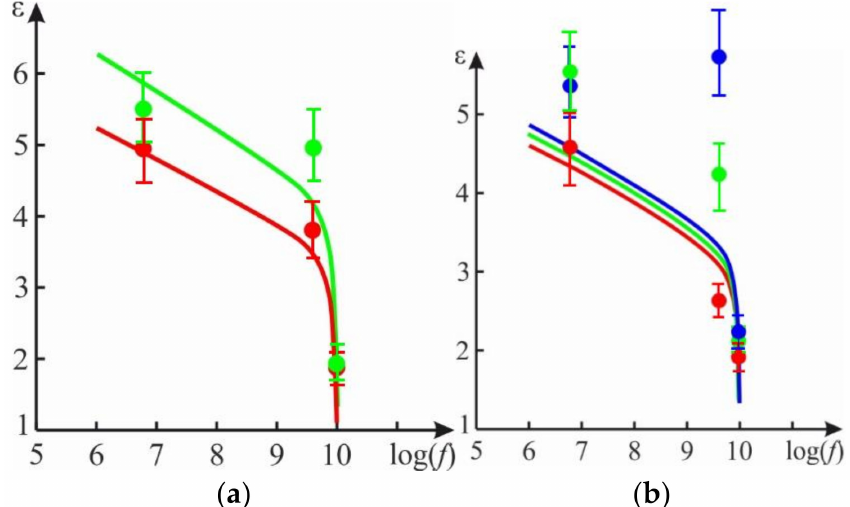
Figure 15. Dielectric constant dependence on frequency. ( a ) Polymer–Ni with q = 0.02452 (red curve) and q = 0.0523 (green curve); ( b ) polymer–Gr with q = 0.0324 (red curve), q = 0.0563 (green curve), and q = 0.0867 (blue curve). Solid line, theory; points, experimental